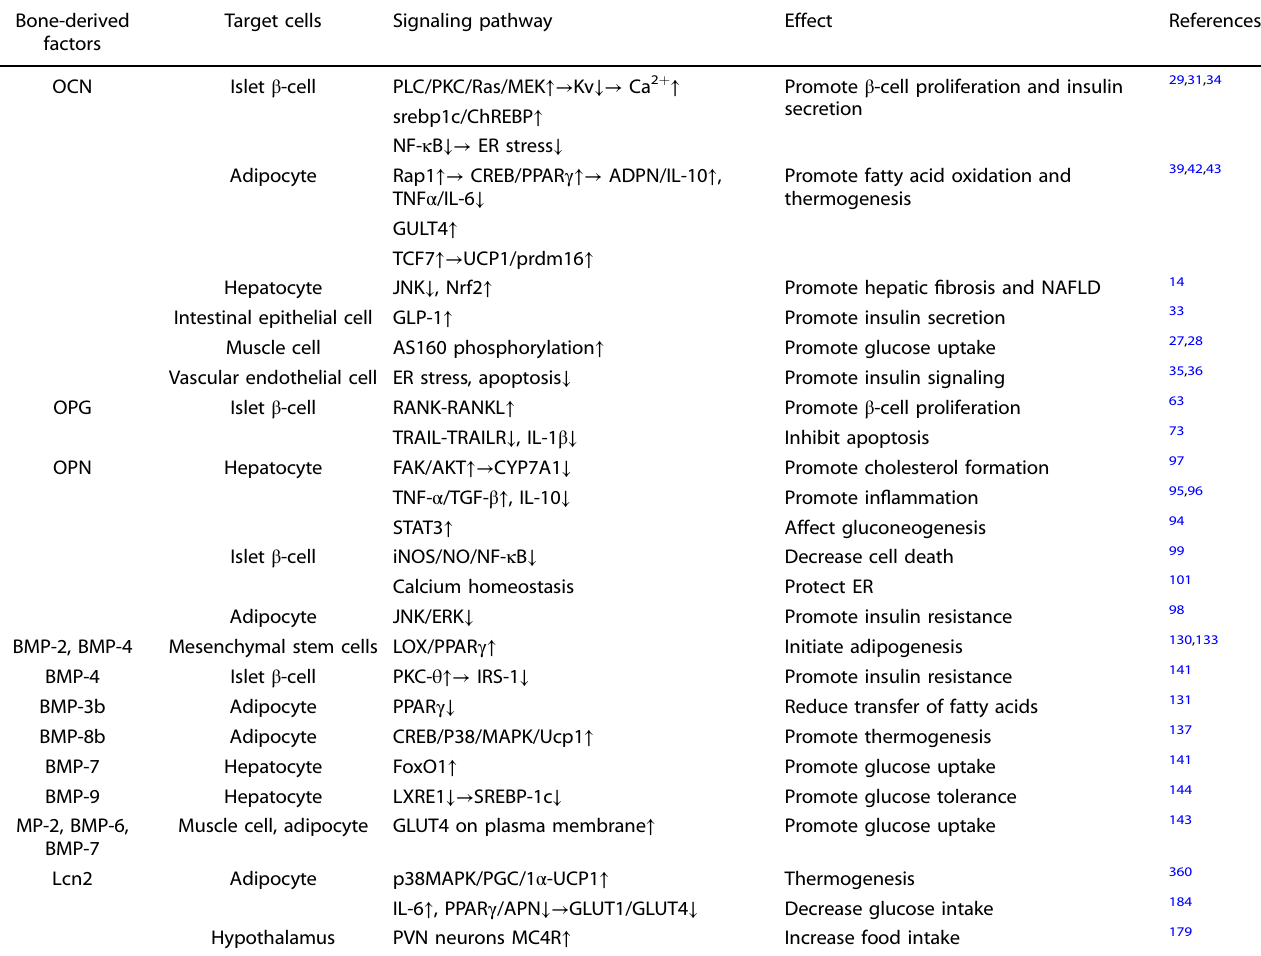
Table 1. Signaling pathways in energy metabolism regulated by factors secreted by bone tissue cells Bone-derived